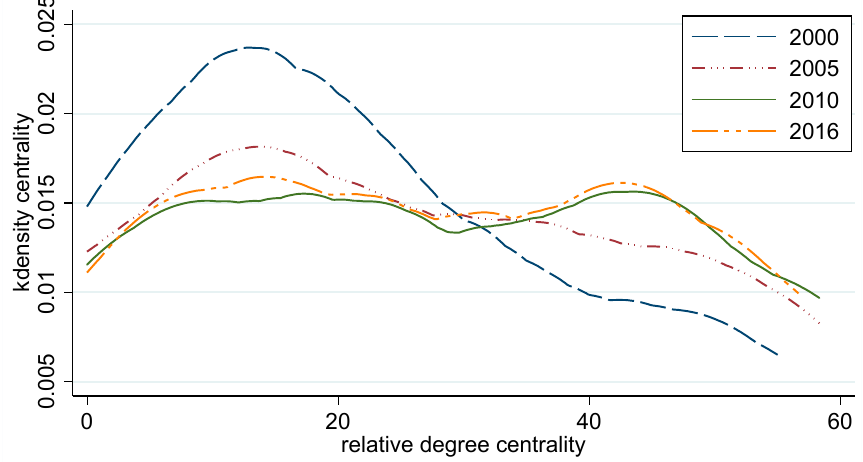
Figure 4. Kernel density estimation of point degree centrality.